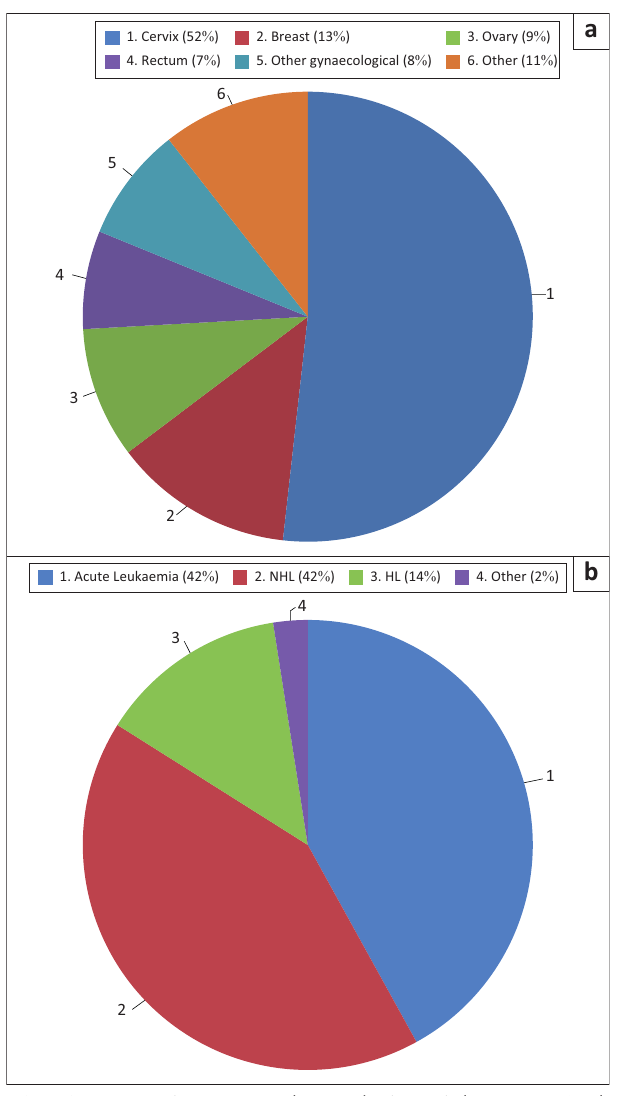
FIGURE 3: Pancytopenia cases at Tygerberg Academic Hospital, Cape Town, South Africa, from January 2016 to December 2017 for which chemoradiation therapy was the cause. (a) Site of NHM, (b) Haematological malignancy (HM) subtypes. Note: Other gynaecological malignancies include endometrial-, vulval- and chorio-carcinoma. HL, Hodgkin lymphoma; HM, haematological malignancy; NHL, non-Hodgkin lymphoma; NHM, non-haematological malignancy.